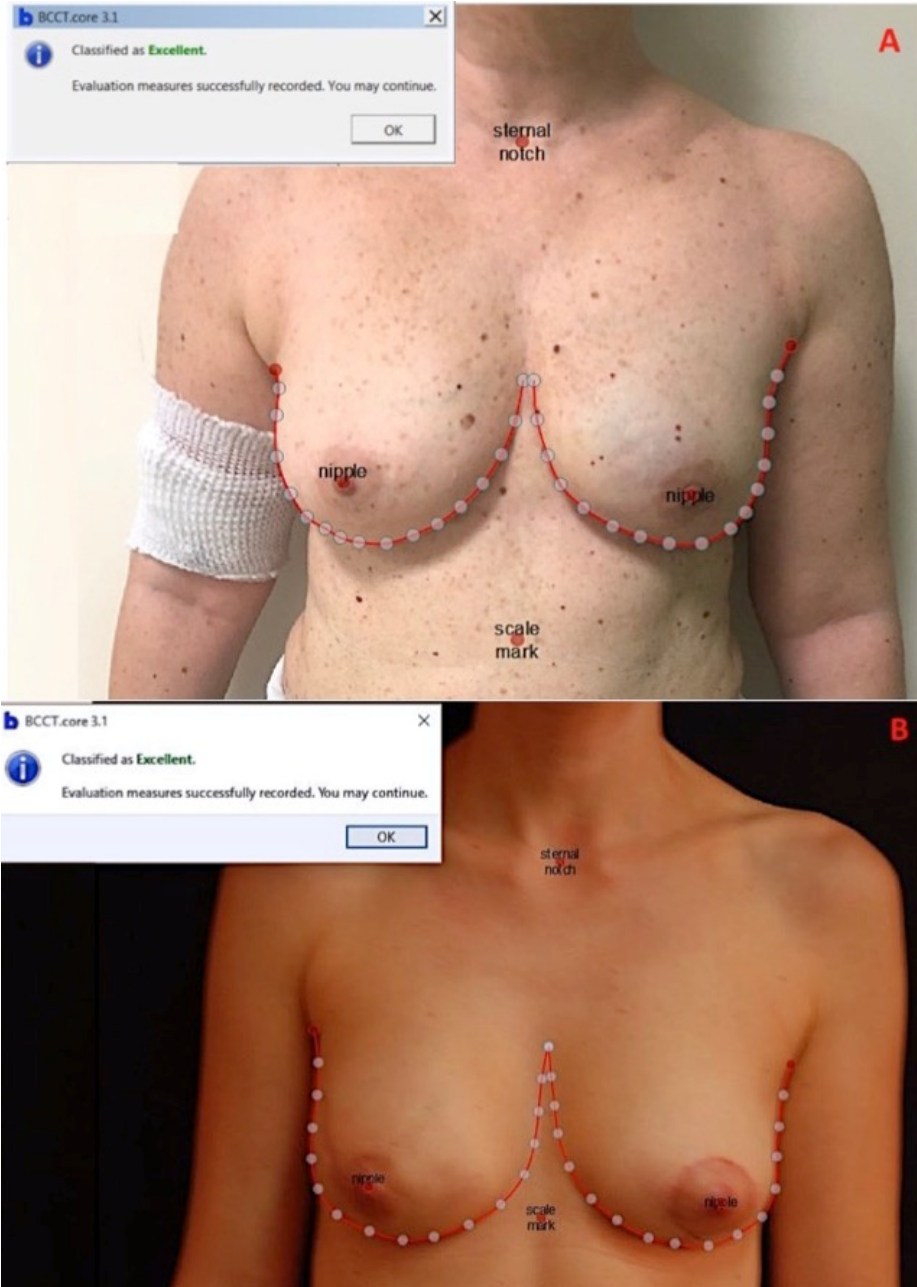
Figure 1. ( A ) Patient after 7 months from NAC-sparing left mastectomy and immediate reconstruction with 290 cc Mentor CPG 312 submuscular prothesis and ADM (dual-plane). This reconstruction was rated as excellent by BCCT.core software and 3.75 (the overall average score) by the questionnaire. ( B ) Patient after 10 months from NAC-sparing right mastectomy and immediate reconstruction with 170 cc Mentor CPG 312 submuscular prothesis and ADM (dual-plane). This reconstruction was rated as excellent by BCCT.core and 3.5 (the overall average score) by the questionnaire. Patients were asked to fill in a questionnaire in the follow-up period (6 months after surgery) to evaluate the outcomes of reconstructive surgery. For each parameter (five), patients gave their evaluation using a 1–4 scale, with 4 being excellent, 3 good, 2 sufficient, and 1 insufficient